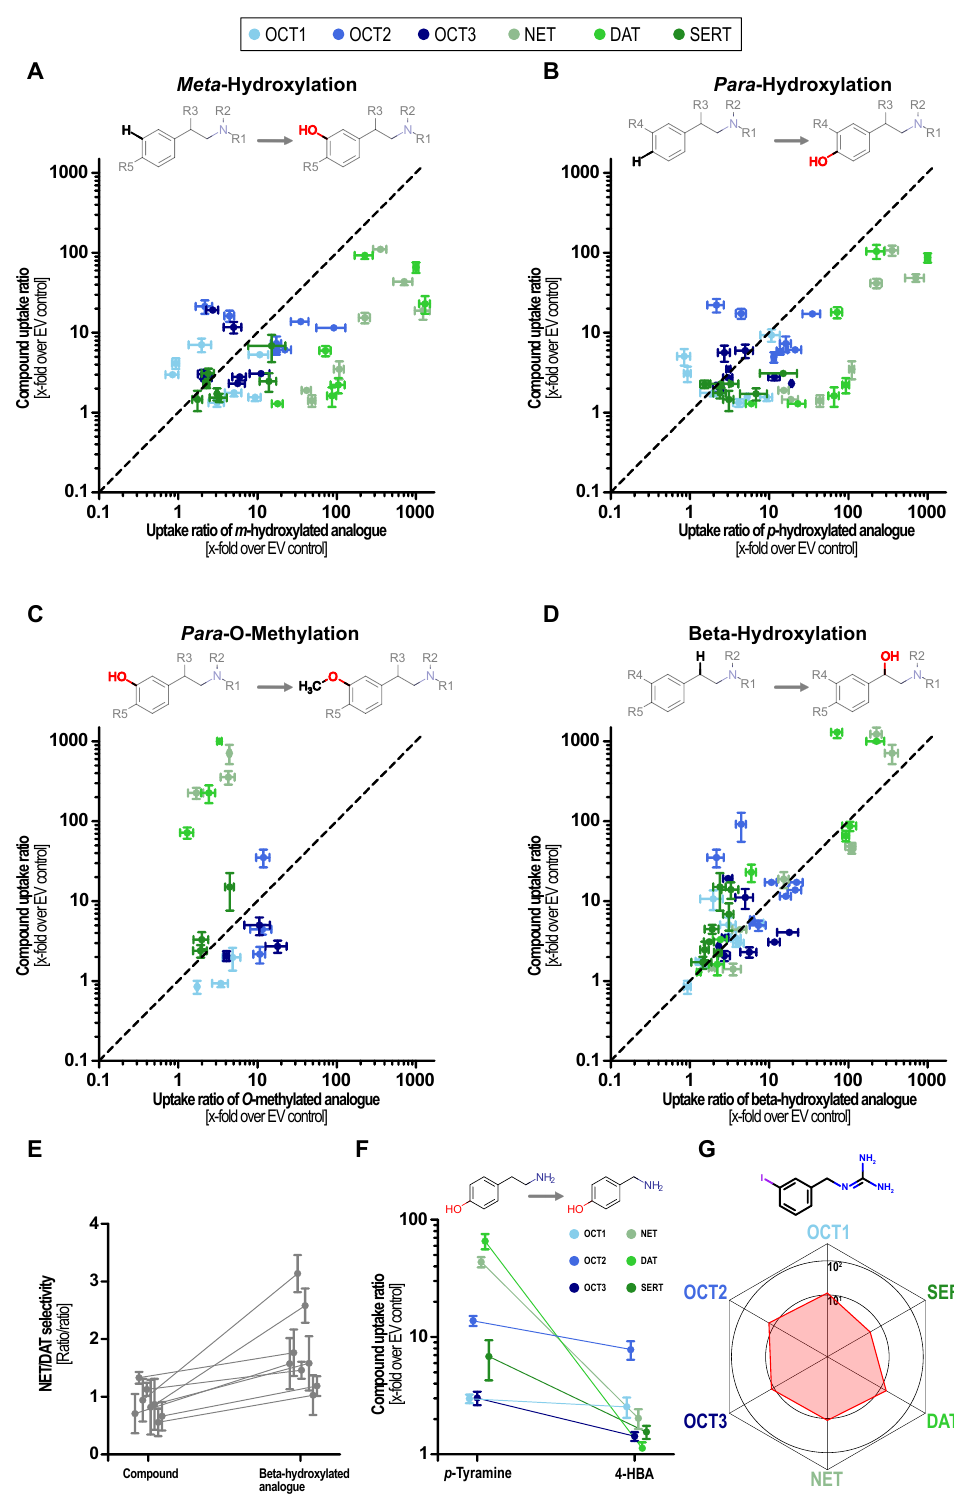
Figure 4. Structure–activity relationship analyses of phenylethylamine-based substrates. Effects of meta - ( A ) and para - hydroxylation ( B ), methylation of para -hydroxy groups ( C ), and beta-hydroxylations ( D ) on transport ratios for MATs and OCTs. The uptake ratio of the parent compound is shown on the ordinate and the uptake ratio of the corresponding substituted compound is displayed on the x-axis. Pairs above the bisection indicate that the uptake ratio is reduced by the respective substitution and pairs below the bisection indicate that the uptake ratio increased it. ( E ) Influence of beta-hydroxylation on NET/DAT selectivity. ( F ) Comparison of uptake ratios of p -tyramine and 4-hydroxybenzylamine (4HBA). ( G ) Balanced uptake ratio of the NET-tracer mIBG by MATs and